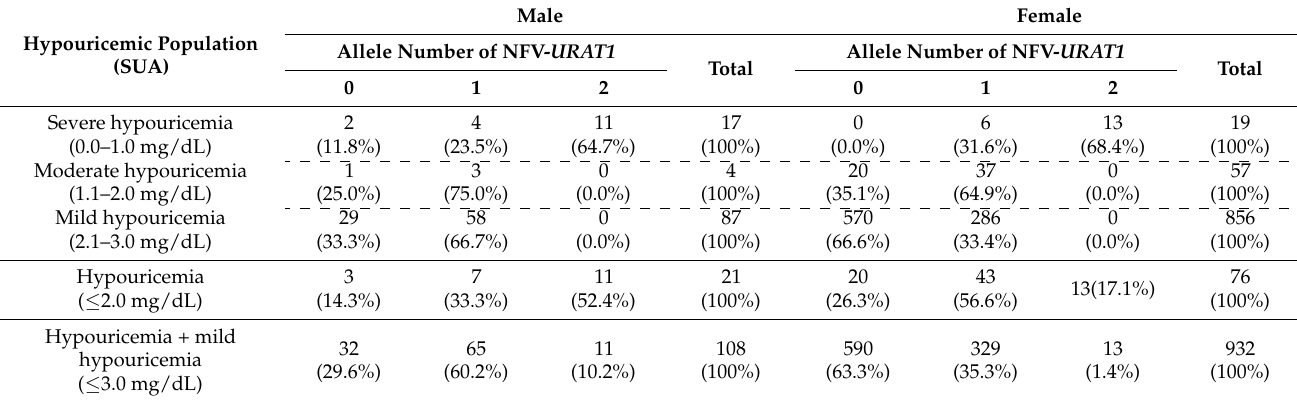
Table 3. The frequency of NFV- URAT1 in 1040 hypouricemic individuals.